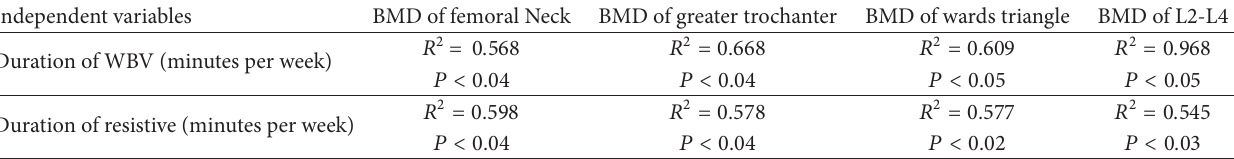
Table 4: Simple linear regression results for WBV and resistive exercise types in obese postmenopausal women. Independent variables BMD of femoral Neck BMD of greater trochanter BMD of wards triangle BMD of L2-L4 𝑅 2 = 0.568 Duration of WBV (minutes per week) Duration of resistive (minutes per week)